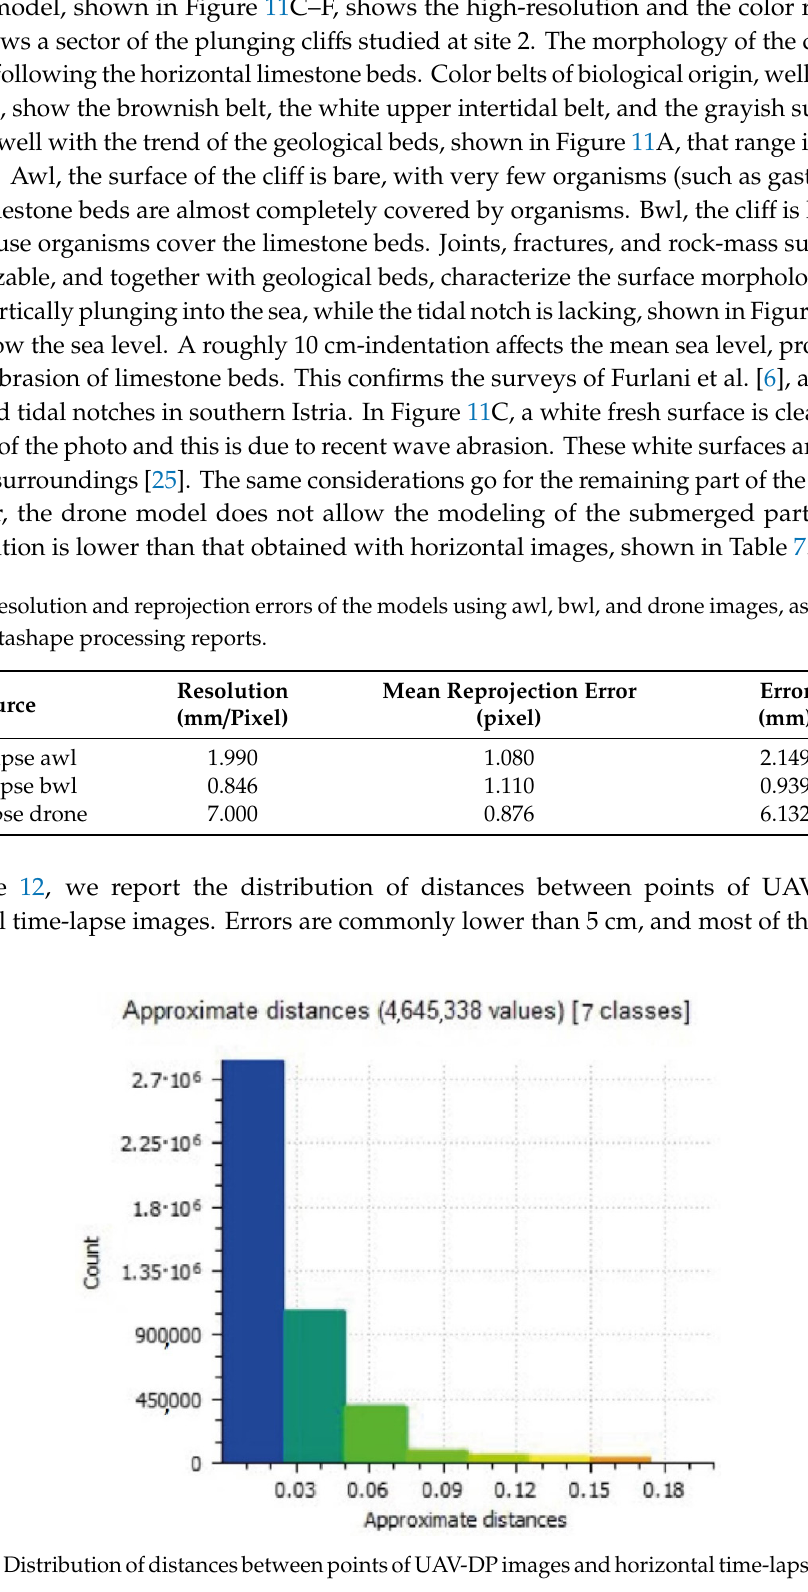
Figure 13. Textured model of site 2 with drone images.